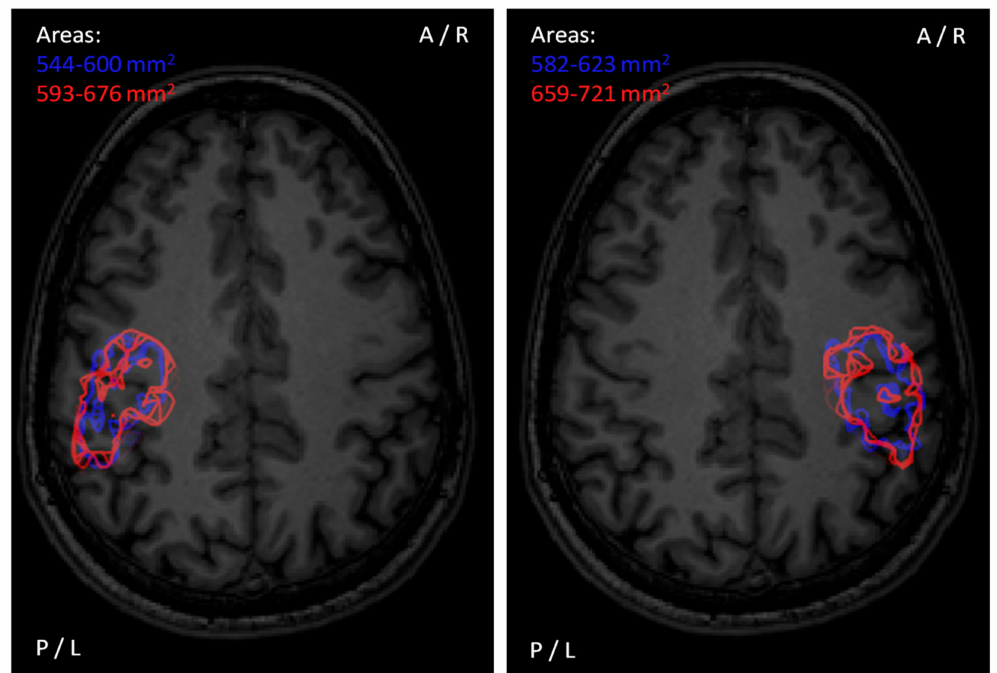
Figure 12. Visualization of motor map outlines of the FDI muscle representation in repeated measurements. Data from each of the experiments were bootstrapped 1000 times, assuming that 10% of the responses observed were false negative. The image is visualized in neurological projection. The blue maps were mapped a bit more densely (mean distance between stimulus locations was 2.6 mm on both hemispheres, as a 3.0 mm grid was used as aid) than the red maps (mean distance between stimulus locations was 2.7 mm and 3.0 mm on the left and right hemisphere, respectively, without a stimulation grid). The 95% confidence limits are indicated for quantified areas in the